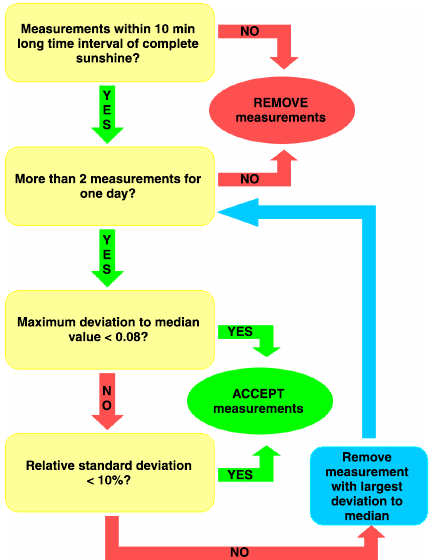
Figure 1. Improved cloud-screening